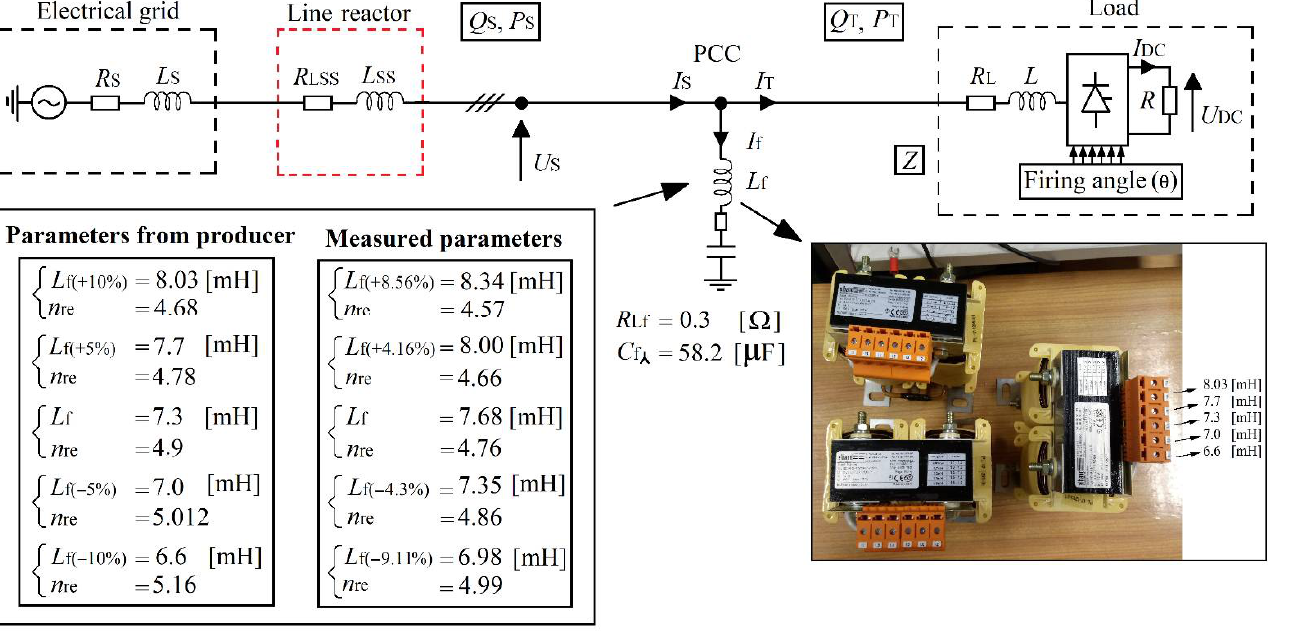
Figure 53. Filter impedance versus frequency characteristics: ( a ) expected characteristics from sim- ulation and ( b ) characteristics measured in the laboratory.